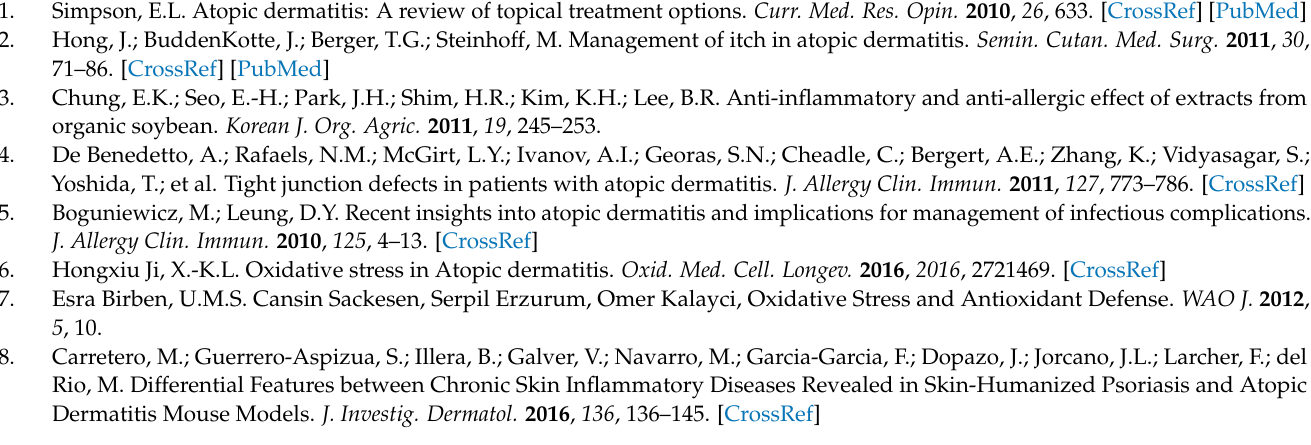
Figure S2: UV Chromatogram of major components of A63 and ST. Figure S3: Full-length Western blot images of Figure 5. Figure S4: Full-length Western blot images of Figure 6. Table S1: List of Primers, Table S2: Comparison of dietary contents in various species of soybean